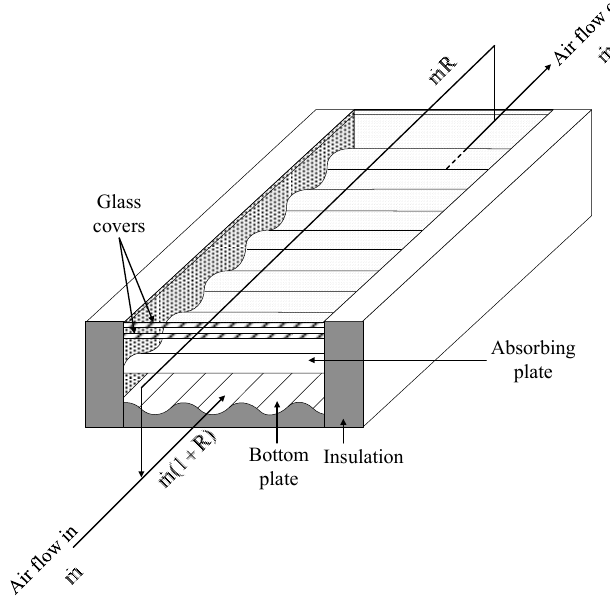
Figure 1. A schematic drawing of recycling double-pass cross-corrugated solar air collector.